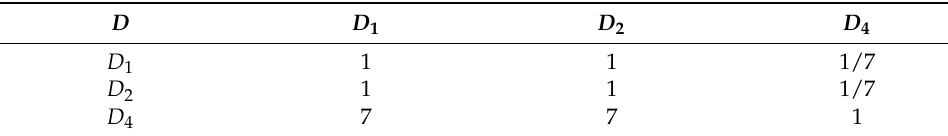
Table 10. Judgment matrix of drainage facility indicators.